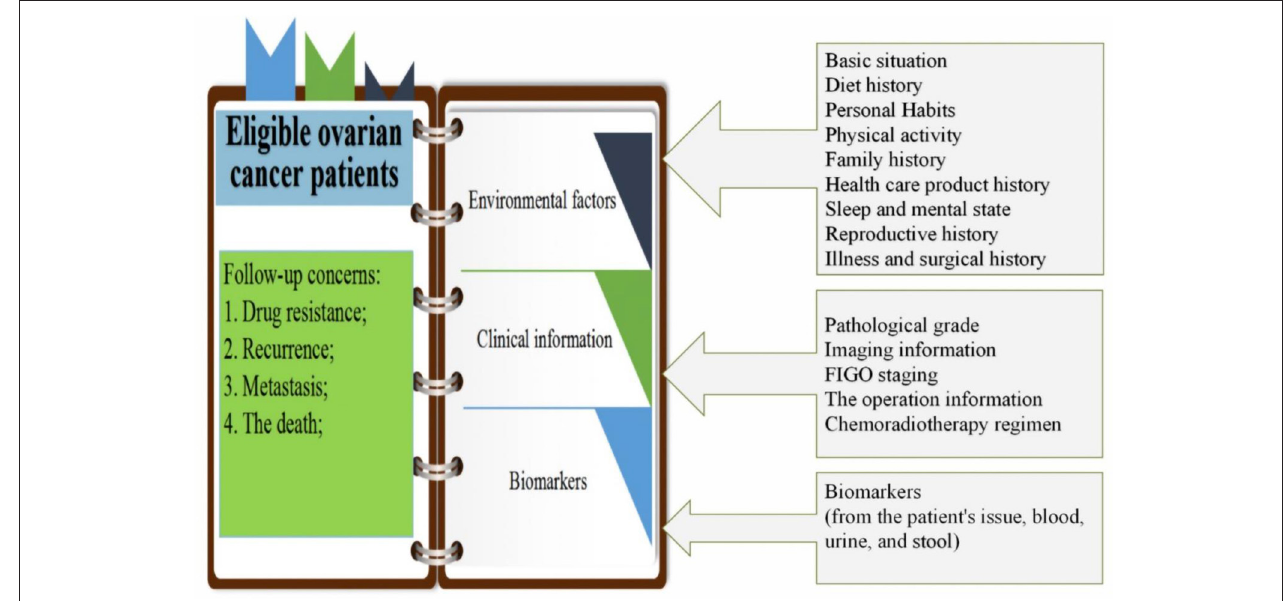
FIGURE 1 | Cohort design for prognosis study of patients with ovarian